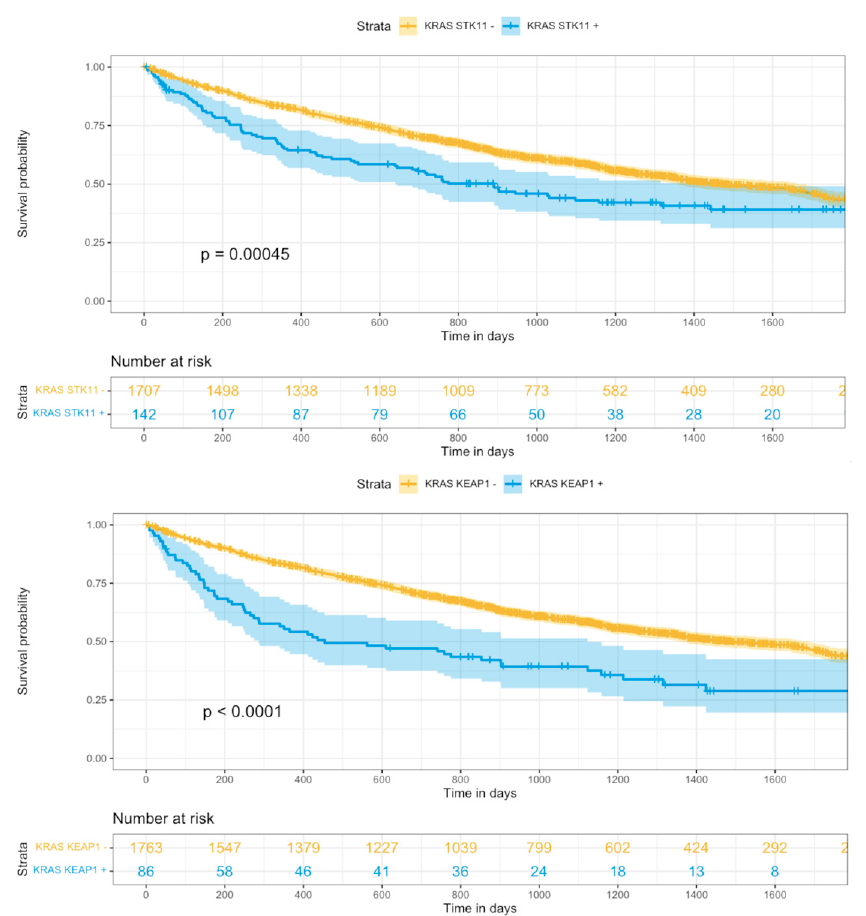
Figure 2. Overall survival curves for KRAS + STK11 and KRAS + KEAP1 markers in all patients. When correlating OS and race within the entire database, there was no statistically signi fi cant di ff erence between white and non-white patients ( p = 0.057).